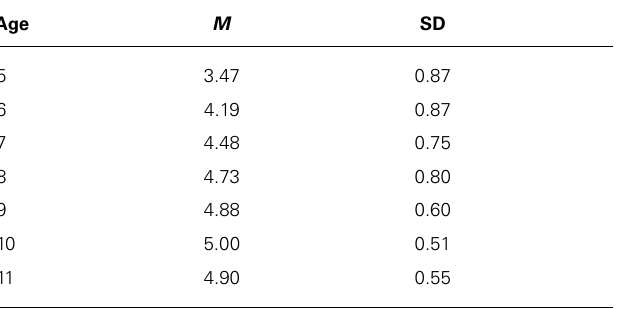
Table 3 | Number of categories used by the participants.